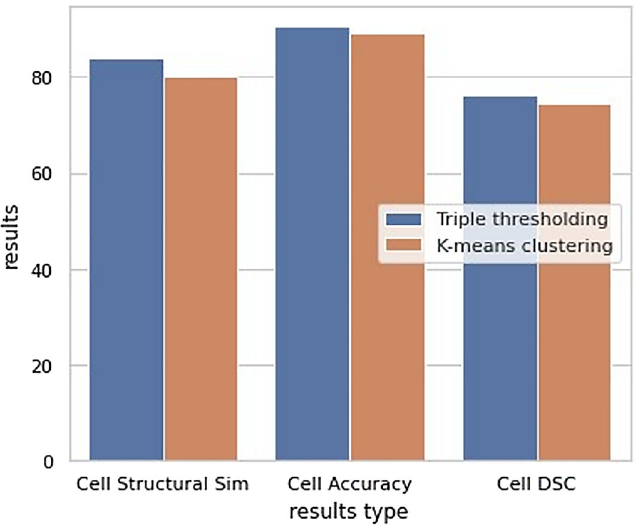
Figure 15. Grouped bar chart for comparison between the K-means clustering and the proposed triple thresholding method.